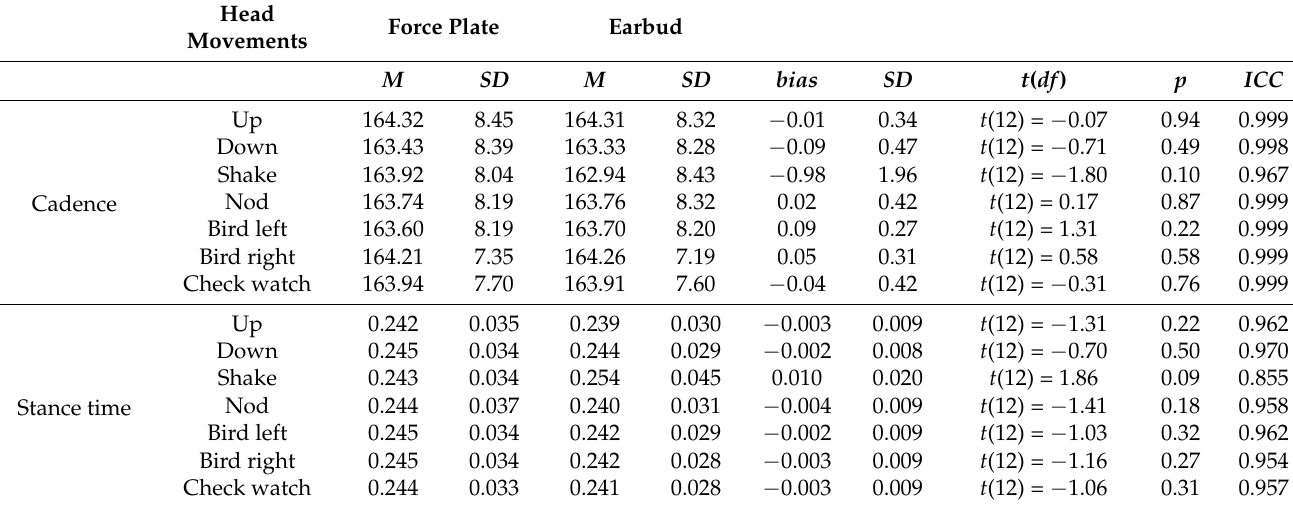
Agreement of the cadence and stance time between the force-plate and earbud methods for the head-movement